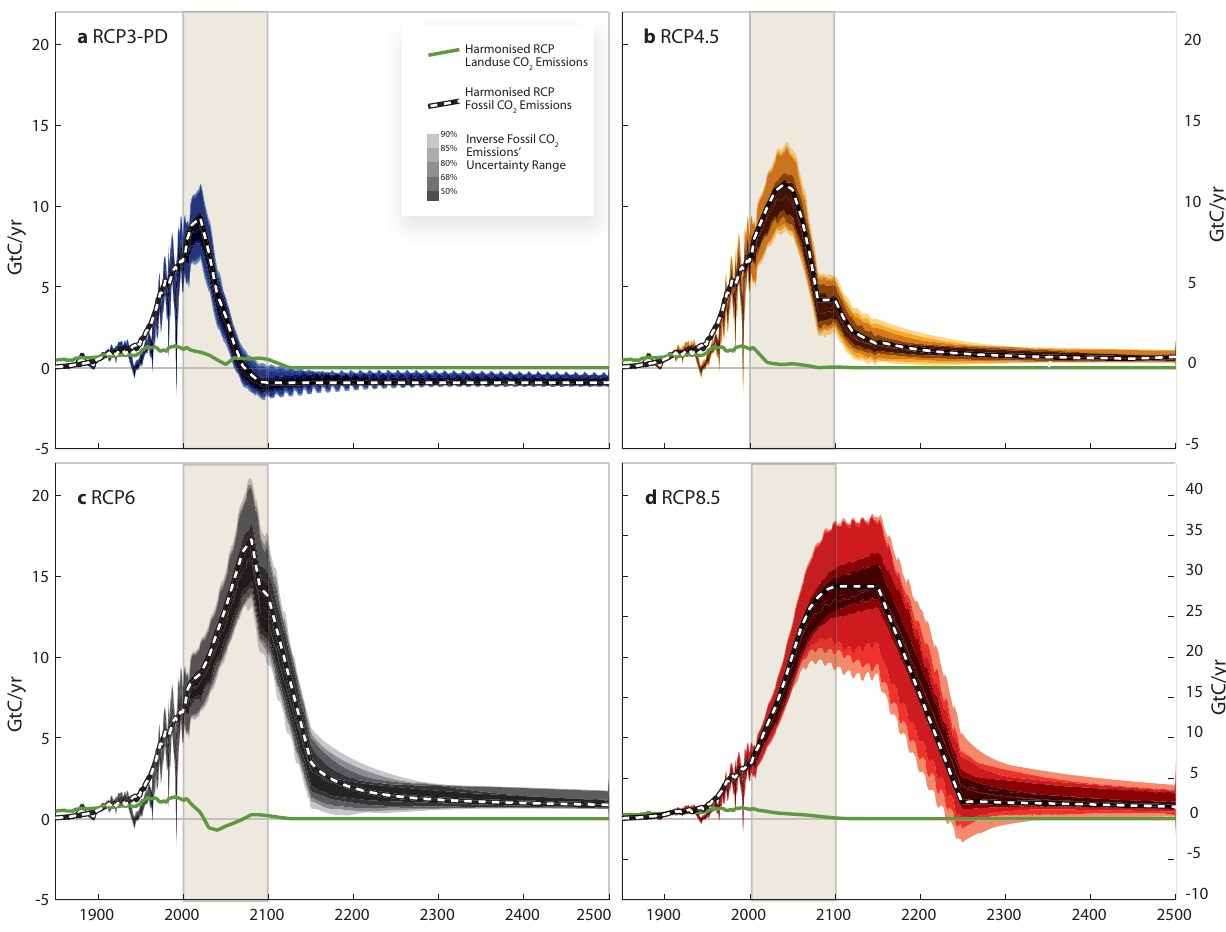
Fig. 4. Inverse fossil CO 2 emissions calculated for prescribed default RCP concentrations. The uncertainty ranges (colored shaded areas) are based on 171 model emulations, combining 19 CMIP3 AOGCM and 9 C 4 MIP carbon cycle model emulations. Harmonized global RCP land-use CO 2 emissions are shown in green, with scaled historical land-use CO 2 emissions in the past based on Houghton and Hackler (2002). Harmonized RCP fossil CO 2 emissions, used to produce default RCP CO 2 concentrations using the same model (MAGICC6) are shown as white-dashed lines (Meinshausen et al., 2011b). Shaded vertical areas from 2000 to 2100 denote the time-span of RCPs, with extensions following thereafter. Due to the focus of the C 4 MIP intercomparison on only one relatively high scenario (SRES A2) up to 2100, the extension of the calibrated C 4 MIP carbon cycle emulations for deeper scenarios and longer time frames is uncertain. Note that the vertical axis in panel (d) is a factor two higher compared to the other